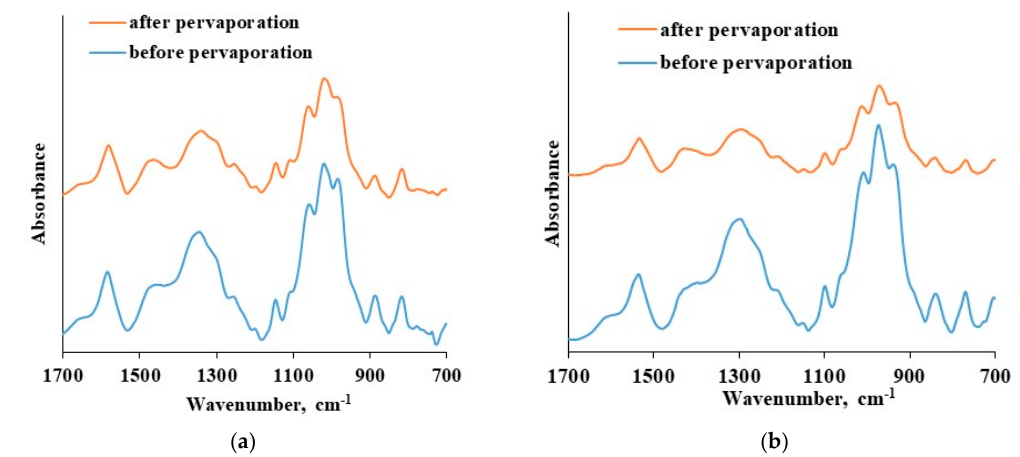
Figure 10. The ATR FTIR spectra of: ( a ) CS-PAN thin selective layer before and after pervaporation, ( b ) CS-PS thin selective layer before and after pervaporation.